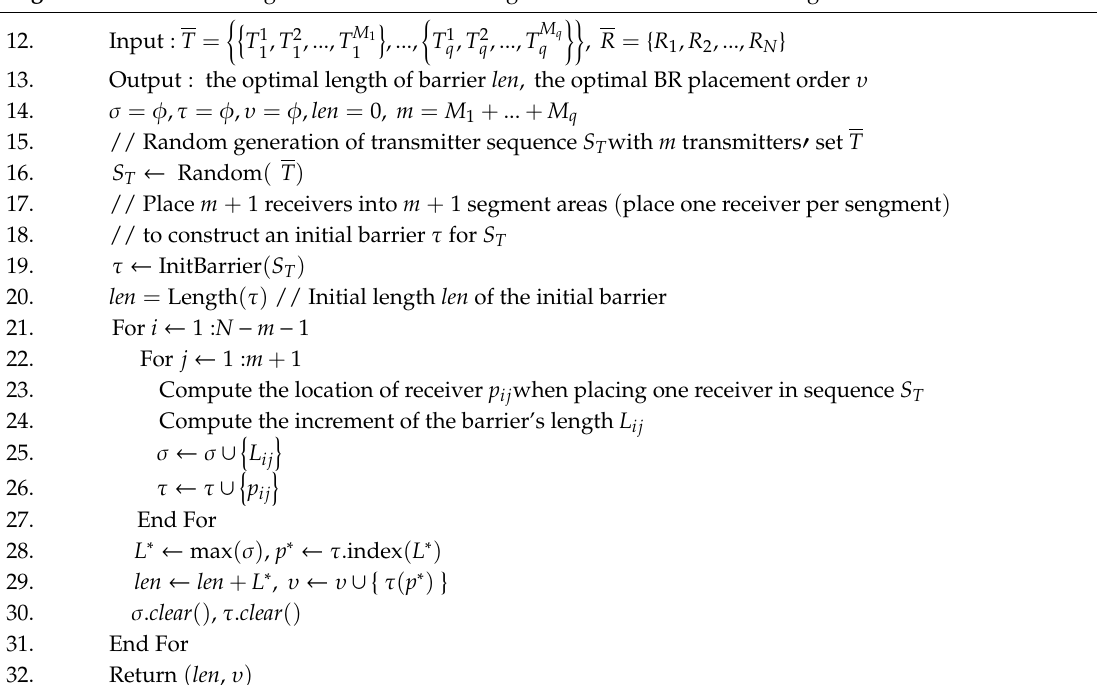
Algorithm 2 Build the longest barrier when heterogeneous transmitters’ order is